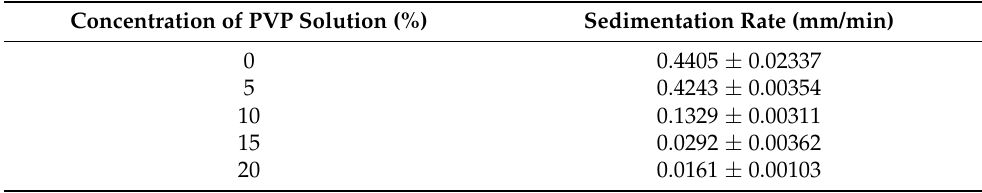
Table 2. The sedimentation rates of HAp particles in PVP solutions.